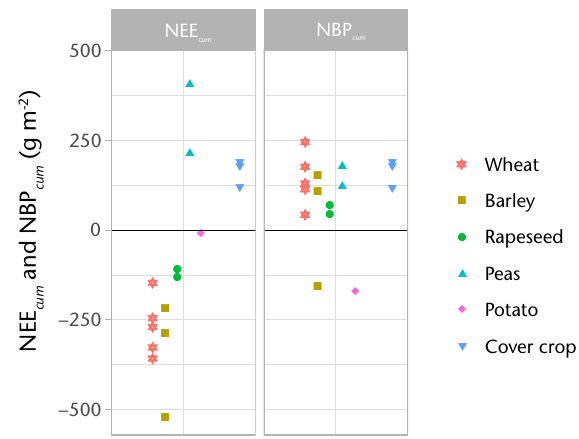
Figure D1. Crop-season-specific cumulative net ecosystem ex- change (NEE cum ) and net biome production (NBP cum ) with a sea- son defined as the time range between the first ploughing after the harvest of the previous crop and the first ploughing after the harvest of the current crop. Each symbol stands for one crop season. Please note that cover crops were only grown during autumn and winter.